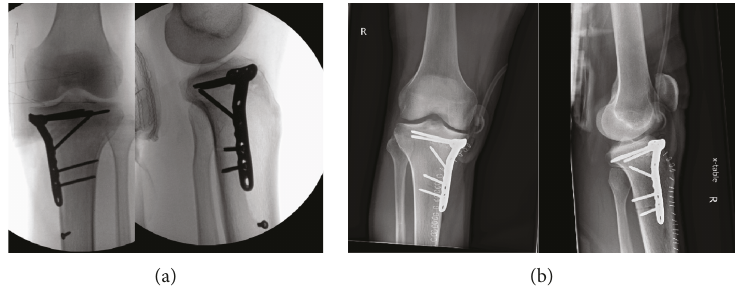
Figure 2: (a) Postoperative radiographs of left knee status post excision, grafting, and open reduction internal fi xation left proximal tibia. (b) Postoperative radiographs of right knee status post excision, grafting, and open reduction internal fi xation right proximal